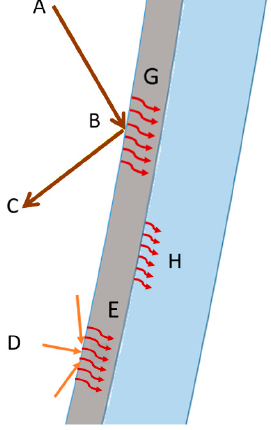
Figure 4. Representative energy diagram in the concentrator.